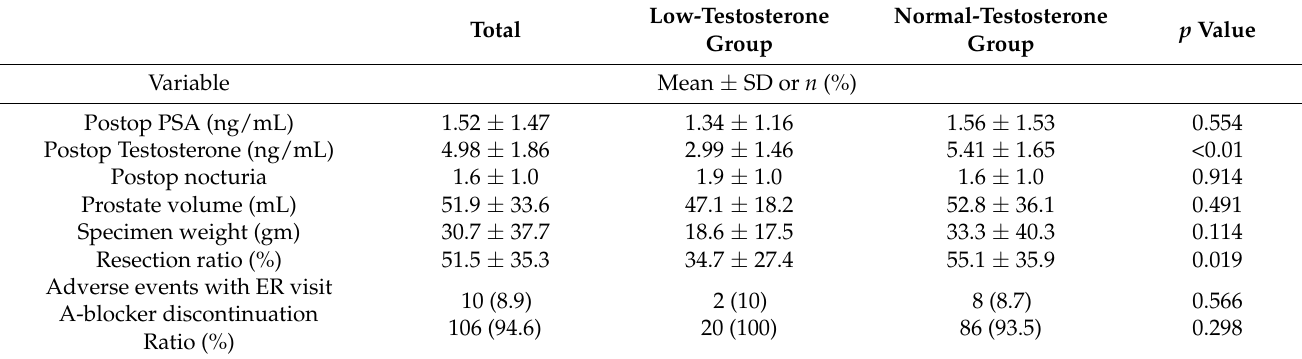
Table 2. Postoperative differences between the low- and normal-testosterone groups. Low-Testosterone Normal-Testosterone Total Group